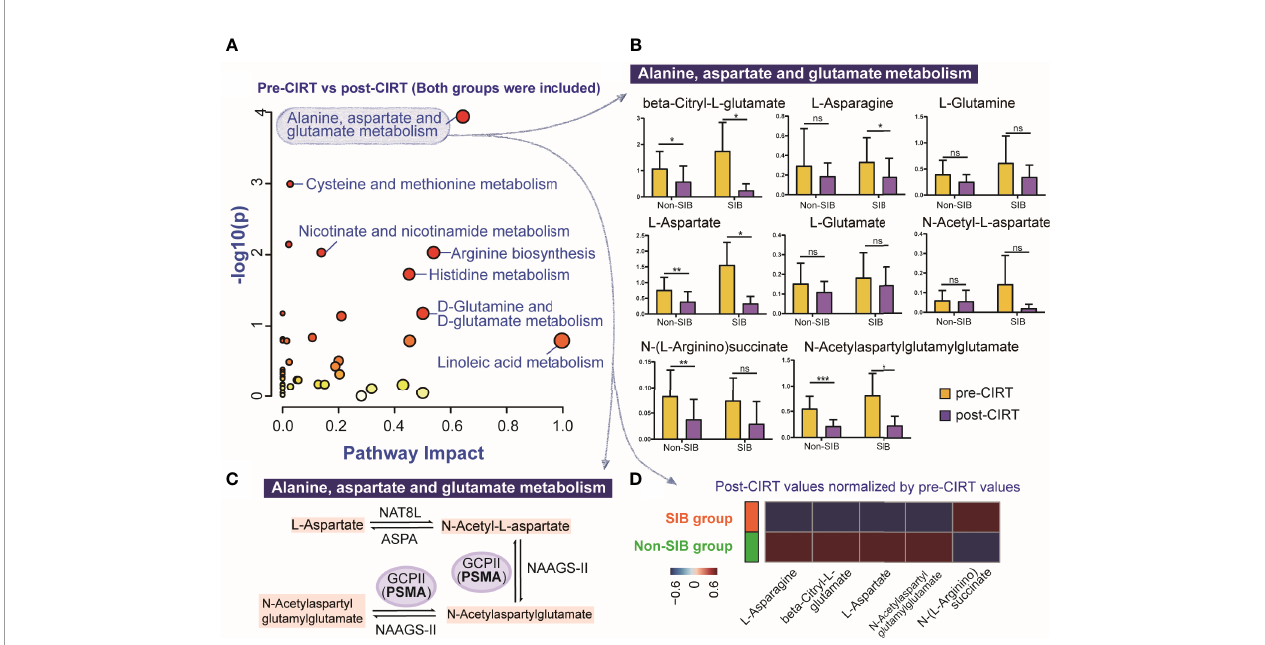
FIGURE 4 | The compare of the most signi fi cantly altered pathway after between the SIB group and the non-SIB group. (A) Pathway analysis of all pre-CIRT and post-CIRT samples in both SIB group and non-SIB group. (B) Box plots of 8 identi fi ed metabolites in alanine, aspartate and glutamate metabolism pathway of pre-CIRT samples and post-CIRT samples in both groups. (C) Schematic diagram of the PCa associated PSMA participated metabolic pathway named alanine, aspartate and glutamate metabolism. (D) The heat map illustrated the comparation of the average level of post-CIRT values normalized by pre-CIRT values of signi fi cantly altered metabolites in alanine, aspartate and glutamate metabolism pathway between two groups.*p < 0.05; **p < 0.01; ***p < 0.001; ns, p > 0.05, no statistical